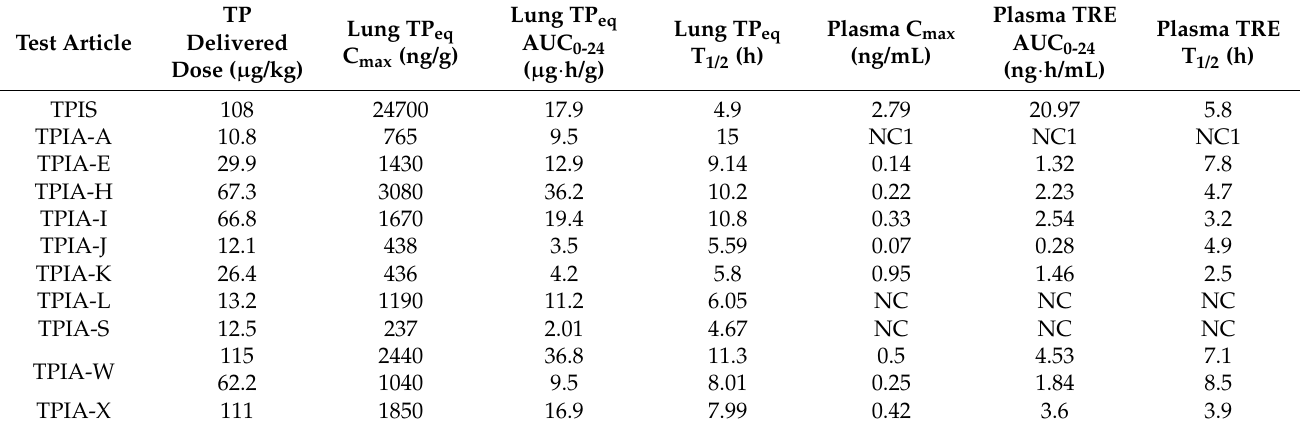
Table 3. Summary of the delivered dose, lung TP eq , and plasma TRE PK following nose-only aerosol administration of TPIA formulations in rats. NC = Not calculated. TP eq is the sum of the tissue content of TP and TRE expressed as molar TP